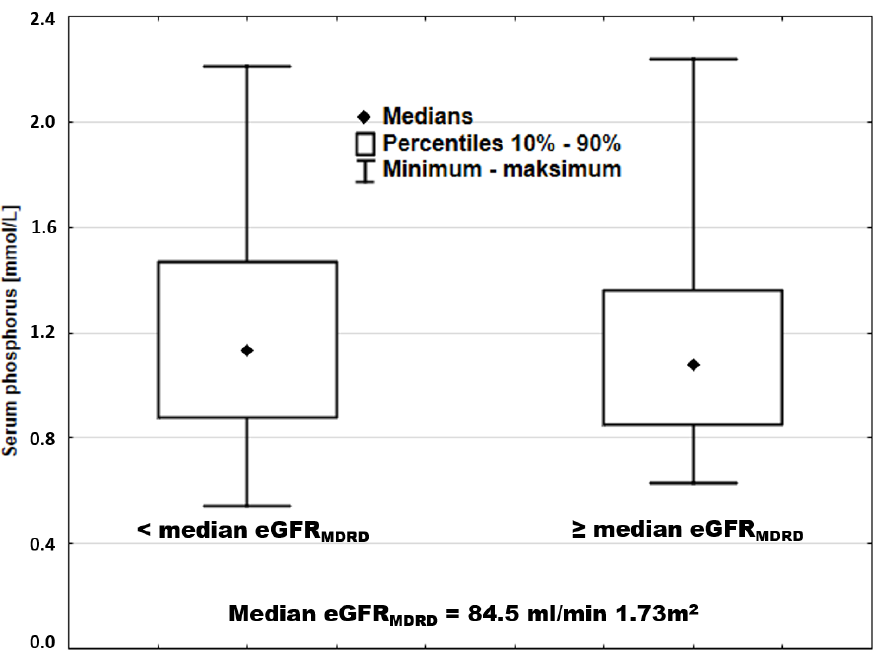
Figure 8. Serum phosphorus in patients stratified according to eGFR MDRD